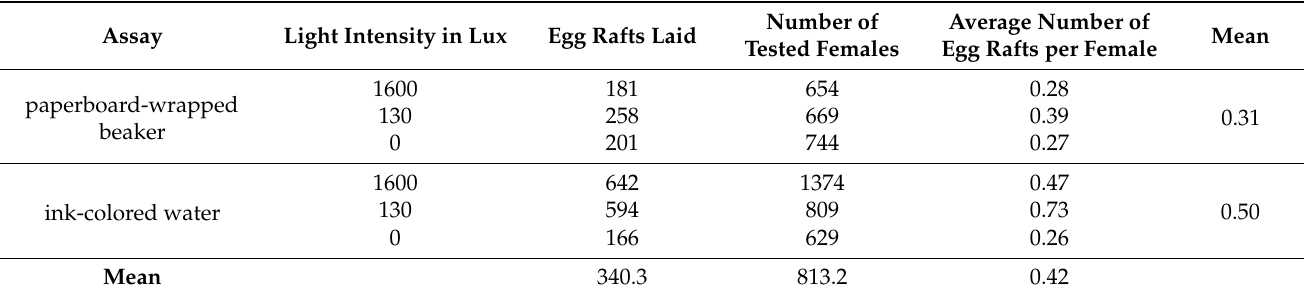
Table 1. Average number of egg rafts per female summarized for the six replications of each light intensity (1600 (16:8 L:D), constant 130 and constant 0 lx) and each assay (paperboard-wrapped beaker and ink-colored water assays).